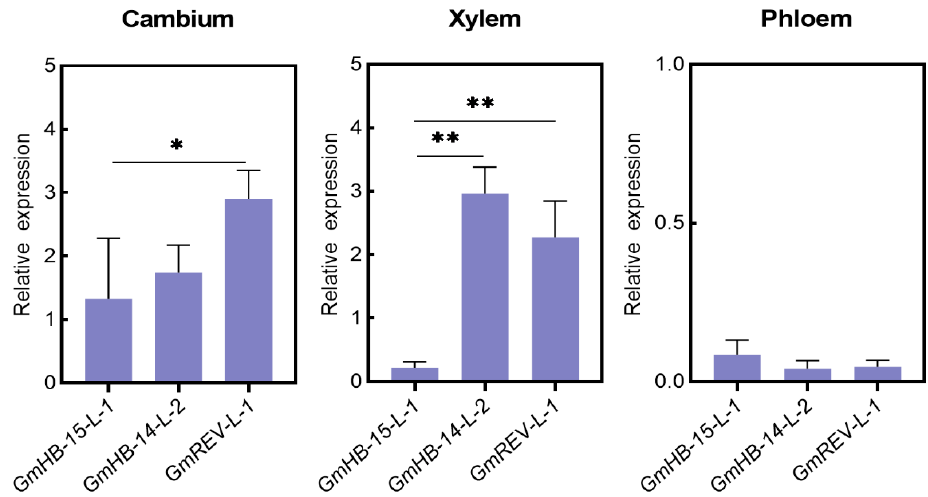
Figure 7. Expression of soybean HD-Zip III genes in various types of vascular cells. Asterisks indicate significant differences between controls and treatments (* p < 0.05, ** p < 0.01).